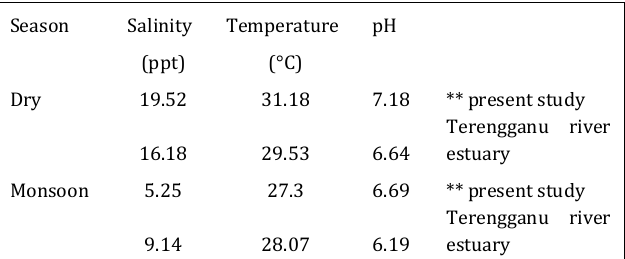
Table 8: Comparison of physico-chemical parameters at Terengganu River Estuary and present study